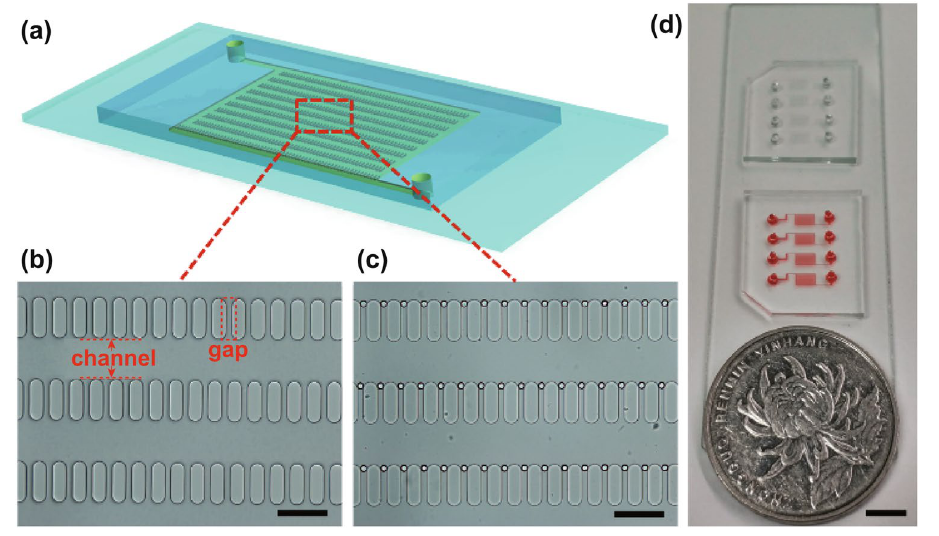
Fig. 1 Bead-based exosome microfluidic chip. a Schematic diagram of the PDMS chip containing a microarray for uniform distribution of microbeads. b Microarray structure in the chip and c microbeads queued in lines along the microarray. Scale bar, 100 µm. d Photograph of the prototype microfluidic chip. Scale bar, 50